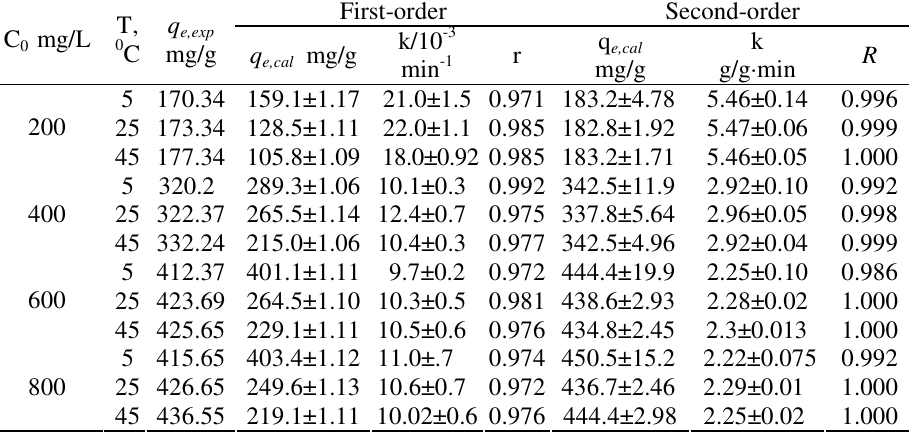
Table 3. Comparison of the experiments and the kinetic models of Acid red3B adsorption on